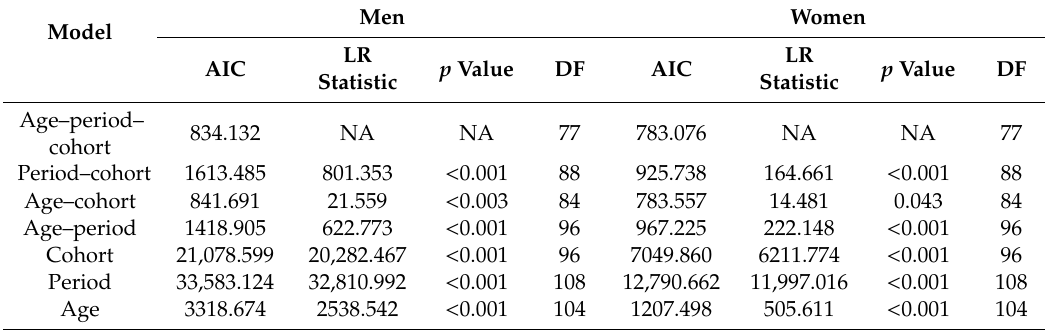
Mortality rates for malignant pleural mesothelioma. Age–Period–Cohort analysis.